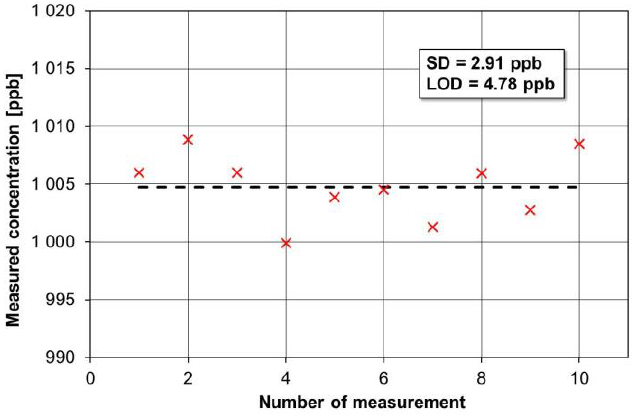
Figure 9. Results of NO concentration measurements.